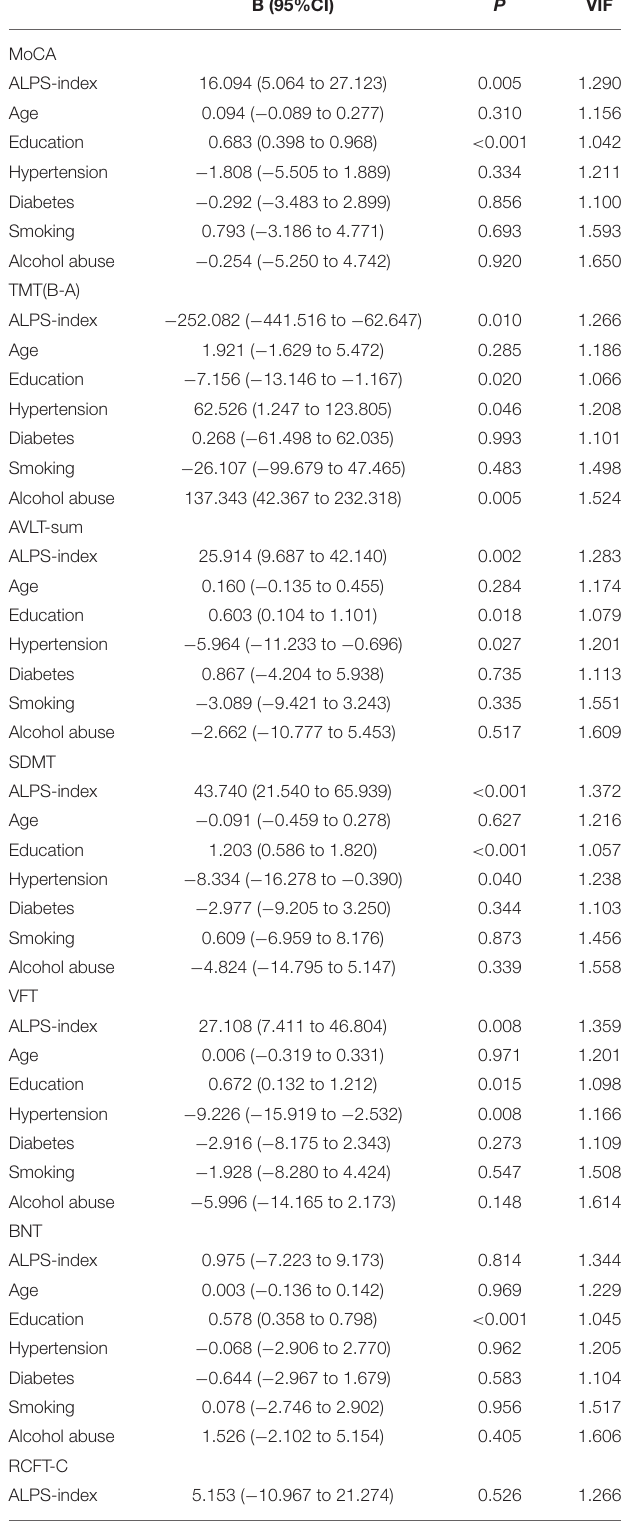
TABLE 3 | Multivariate regression linear analysis between neuropsychological test in CSVD and vascular